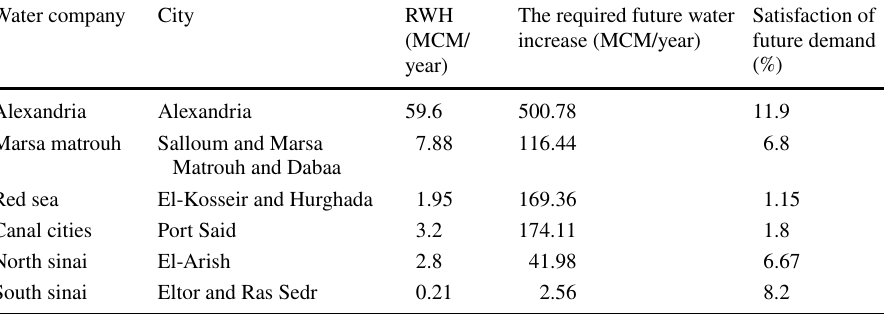
Table 5 RWH Percentages share to satisfy future water according to HCWW 2015 to